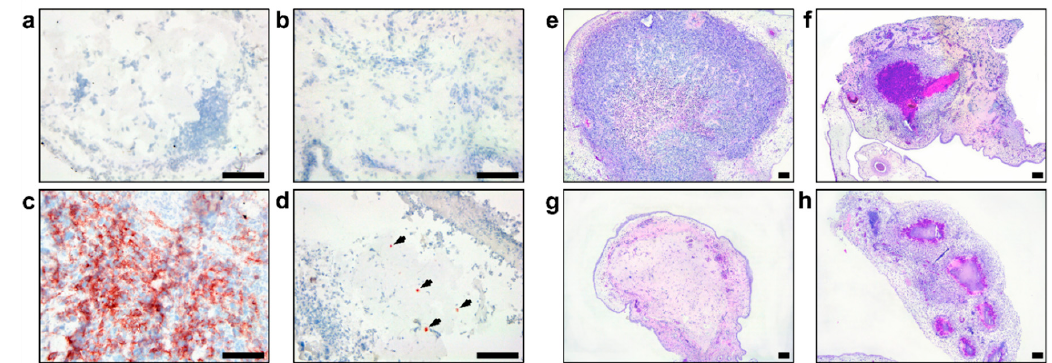
Figure 6. Immunohistochemistry of the Zika virus (ZIKV) antigen: ( a ) Isotype control staining of the glioblastoma stem cells (GSC) 528 tumor; ( b ) Mock-inoculated GSC 157 tumor; ( c ) GSC 528 inoculated with ZIKV E + 102CpG; ( d ) GSC 157 inoculated with ZIKV E + 102CpG (arrows). H&E staining of mock ( e : GSC 528; f : GSC 157) and ZIKV-inoculated tumors ( g : GSC 528 inoculated with ZIKV E + 102CpG; h : GSC 157 inoculated with ZIKV E + 102CpG). Scale bars are 0.1 mm.